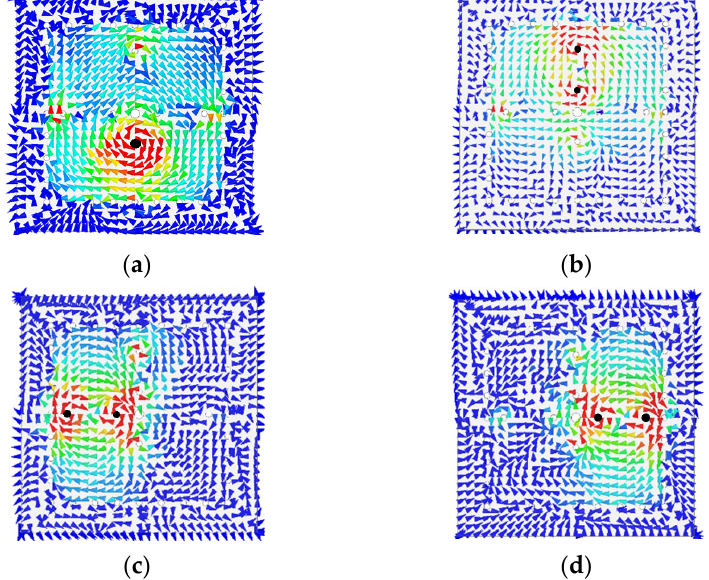
Figure 4. The magnetic field distribution on the bottom surface of metal layer M2 at the ( a ) first, ( b ) second, ( c ) third, and ( d ) fourth passband resonance frequencies.